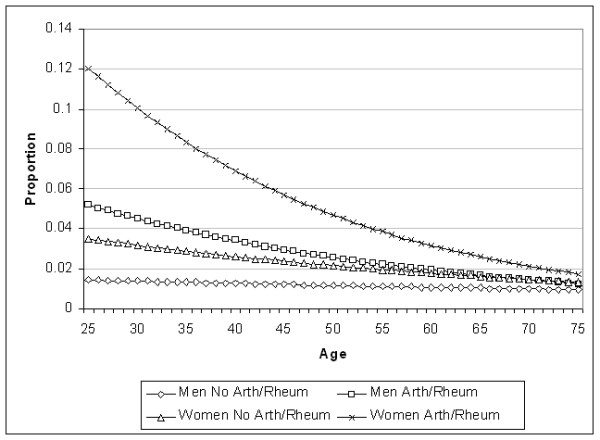
Fitted proportions: logistic regression model for panic disorder. The logistic equation is: -4.08 + 1.85 (Arth/Rheum) - 0.0084 (Age) + 1.21 (female sex) - 0.021 (Arth/Rheum by Age) -0.01164 (Age by Sex). Fitted proportions: odds/1 + odds